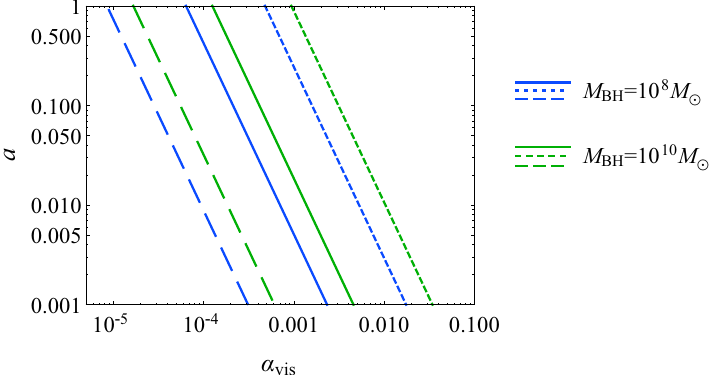
Figure 11. Relations of parameters a BH and α vis for various M BH and ˙ m for period T (cid:48) p ≈ 1.2 × 10 3 years of the precession of both the black hole and the inner part of the accretion disc: dashed, solid, and dotted lines correspond to ˙ m equal to 0.001, 0.01, and 0.1 in Eddington units,